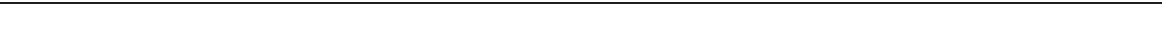
Fig. 3 Intermittent PTH treatment induces merged distribution in vivo. a – c Micro-computed tomography (micro-CT) analysis of the distal, femoral metaphyseal regions. Twelve-week-old female mice were given the vehicle or PTH (40 µ g kg − 1 per day, 5 days per week) via subcutaneous (s.c.) injection and were evaluated 1, 3, and 6 weeks later; n = 20 in the control group, n = 6 – 8 in each PTH-treated group. Data are presented as means ± SDs. * p < 0.05; ** p < 0.01; **** p < 0.0001; NS, not signi fi cant (one-way ANOVA). a Representative micro-CT three-dimensional (3D) images. Scale bar, 1,000 µ m. b Cortical bone ratios (cortical bone volume/total bone volume; CV/TV). c Bone matrix densities (bone volume/total volume, BV/TV). d – f Representative, intravital, two-photon, microscopy tiling MIP images of skull bone tissues of Col2.3-ECFP/TRAP-tdTomato mice taken 1, 3, or 6 weeks after PTH treatment ( d , 1w-PTH; e , 3w-PTH; f , 6w-PTH). Cyan, mOBs expressing Col2.3-ECFP; red, mOCs expressing TRAP-tdTomato; blue, bone tissues (SHG). Scale bar, 300 µ m. Magni fi ed images of representative distributions of mOBs and mOCs in either group (right panels). Scale bar, 100 µ m. g , h Areas of mOCs and mOBs per visual fi eld; n = 120, collected from 12 tiling images from the six mice in each group. Data are presented as means ± SDs. **** p < 0.0001; NS, not signi fi cant (Kruskal – Wallis